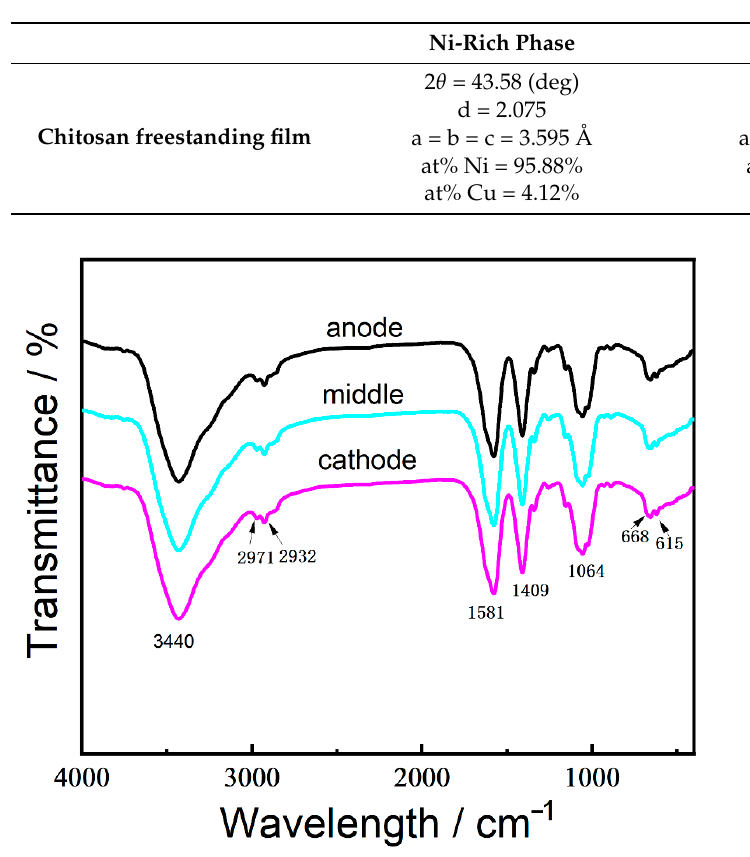
Figure 7. FTIR spectra of three different positions of the freestanding hydrogel film (anodic, middle, and cathodic film).